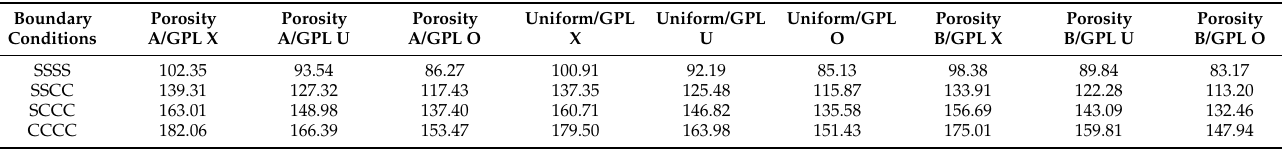
Table 4. Free vibration frequency ω (rad/s) of GPL reinforced porous composite plate with differ- ent porous distributions and GPL distribution patterns.